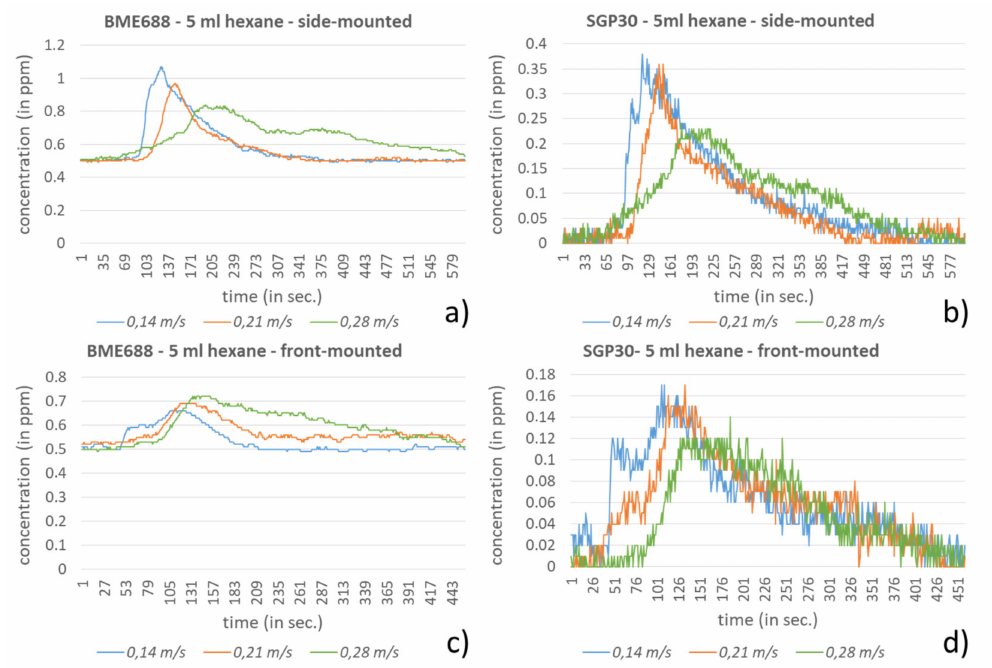
Figure 18. Results for the detection of 5 mL hexane during passing by with the H20-robot in different speed levels and with front- and side-mounted sensor node. ( a ) Response of the side-mounted BME688 and ( b ) SGP30. ( c ) Response of the front-mounted BME688 and ( d ) SGP30.